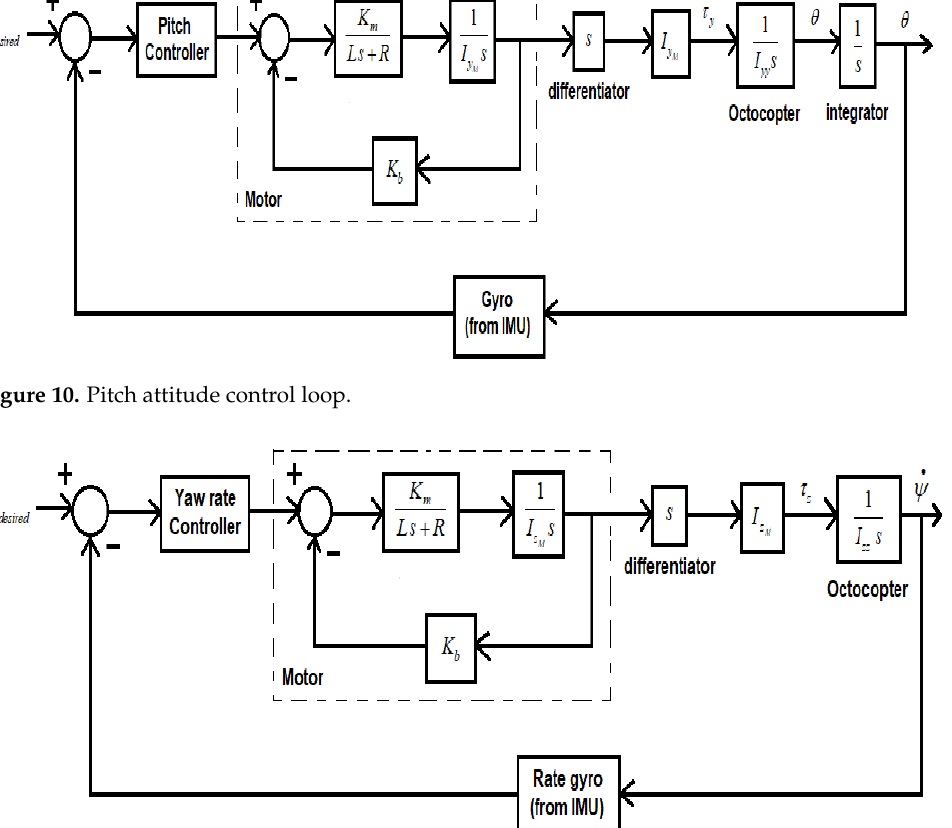
Table 2. Controller design specifications.